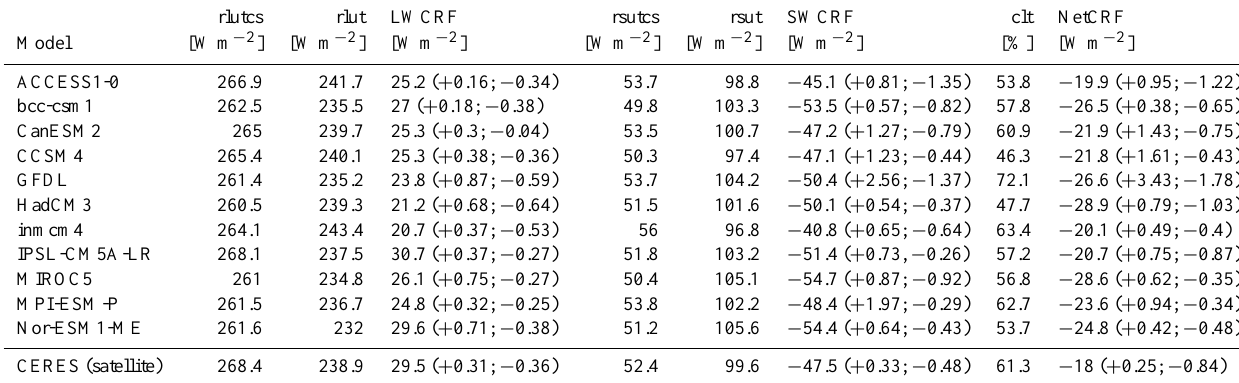
Table 1. Global mean radiative forcing for the CMIP5 models and CERES satellite data averaged over 10 years. The abbreviation rlut stands for long-wave upward all-sky radiation at the top-of-the-atmosphere and rlutcs for clear-sky instead of all-sky. The abbreviations rsut and rsutcs are the same for shortwave radiation, respectively. Numbers in parentheses represent the minimum and maximum anomaly from the 10-year means compared with yearly values.